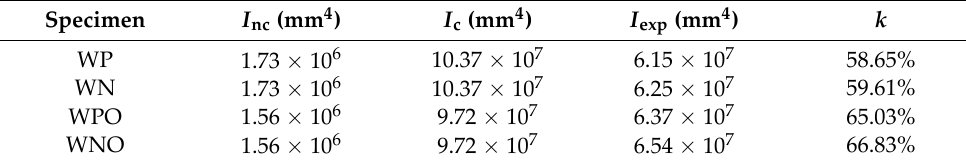
Table 4. Degree of composite action related to